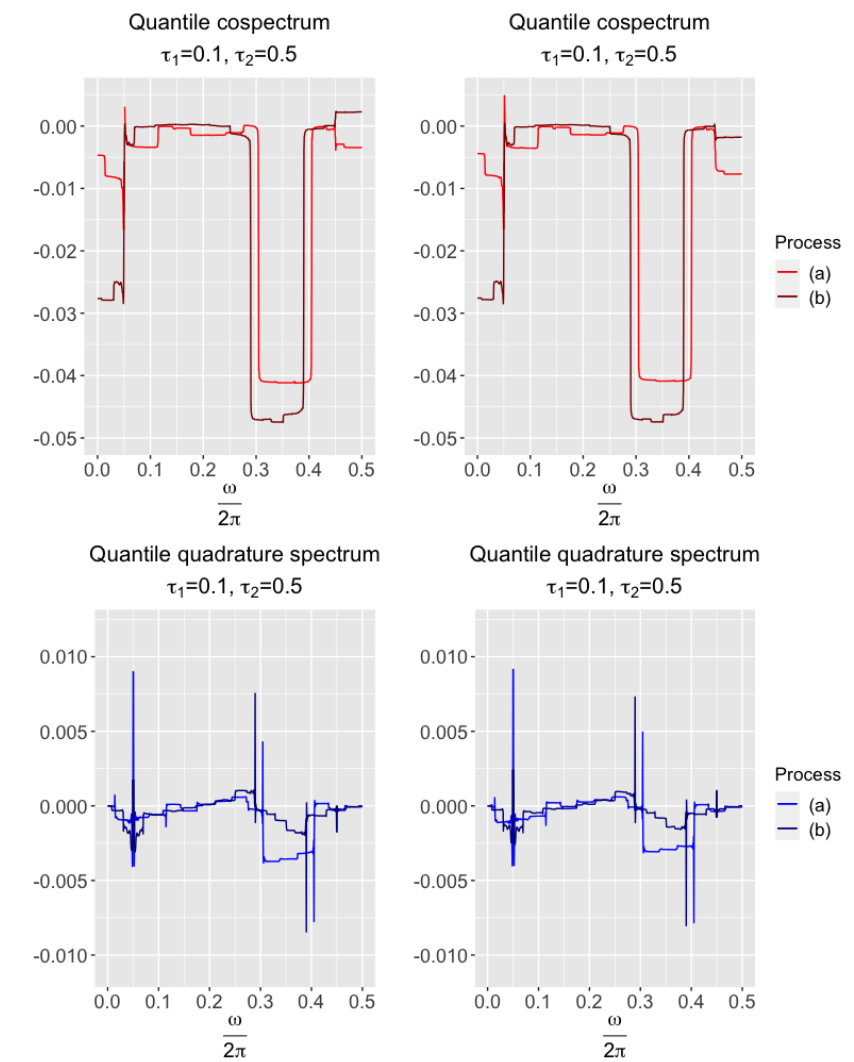
Figure 5. Estimates of the hypothetical quantile cospectrum and quantile quadrature spectrum between X t ,1 and X t ,3 for large sample size ( T = 2000) simulations of processes (a) and (b) in Scenario 4. The left hand panels correspond to particular realisations of both processes, whereas the right hand panels to other